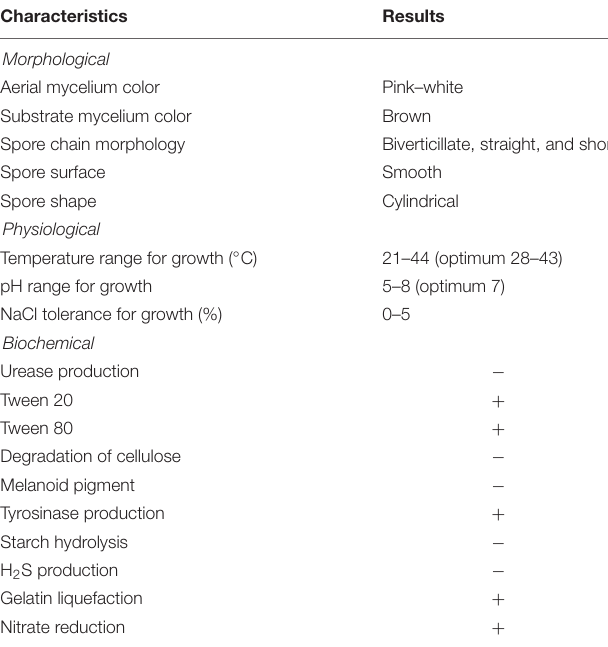
TABLE 3 | Nutrition Utilization and Antibiotic characteristics of strain